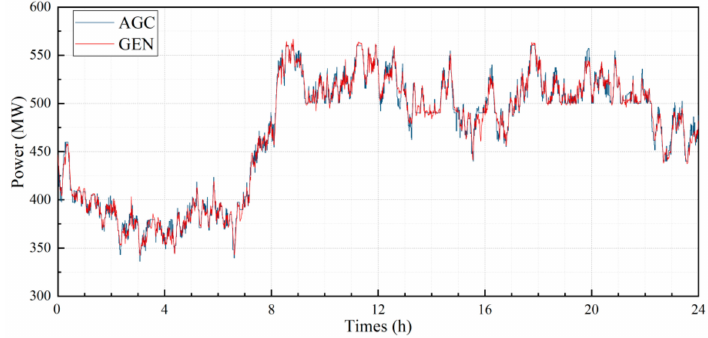
Figure 8. The generator follows the AGC instruction curve for 24